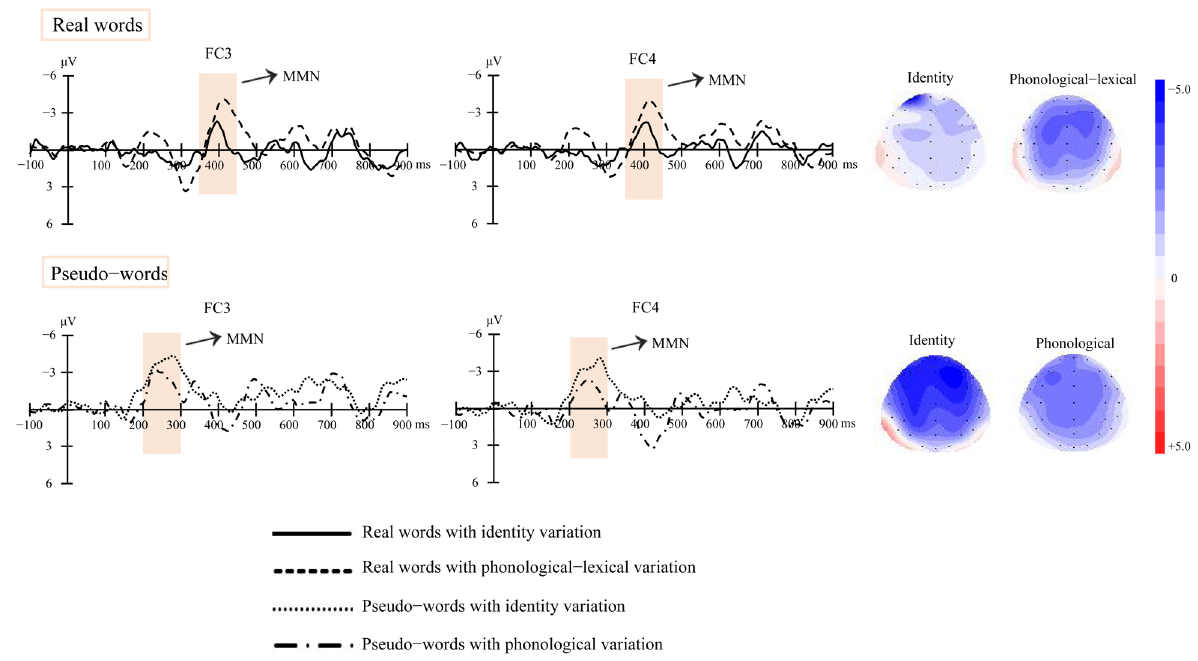
Figure 3. MMN waveforms evoked by the different deviant conditions at electrode locations FC3 and FC4, and the topographies of MMNs (real words: 350–450 ms; pseudo-words: 200–300 ms) in different deviant conditions.